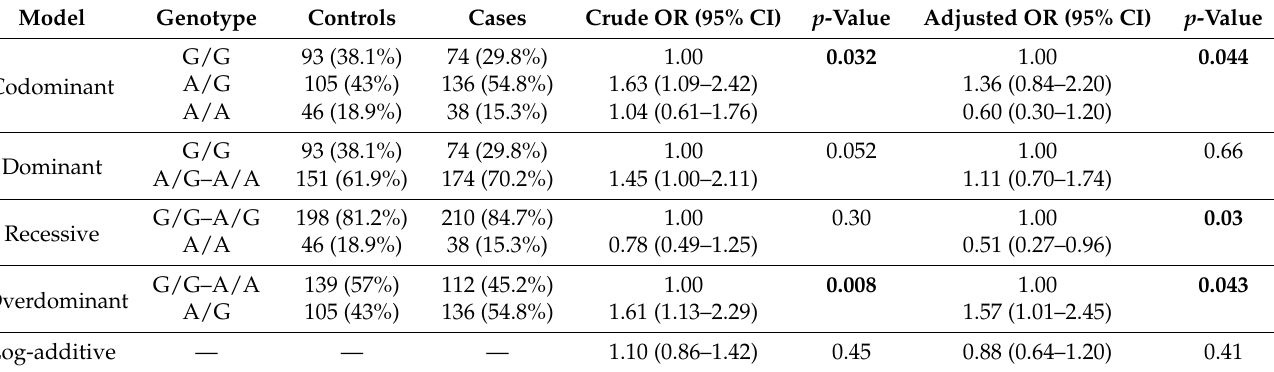
Table 4. Risk of alopecia areata by genetic association models of MIR17 rs4284505